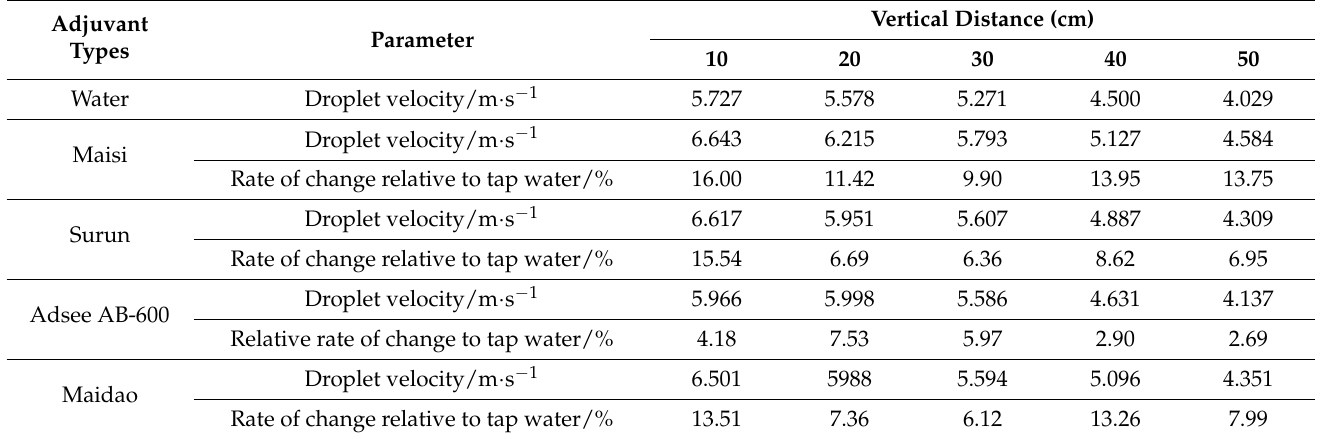
Table 6. Droplet velocity distribution at different